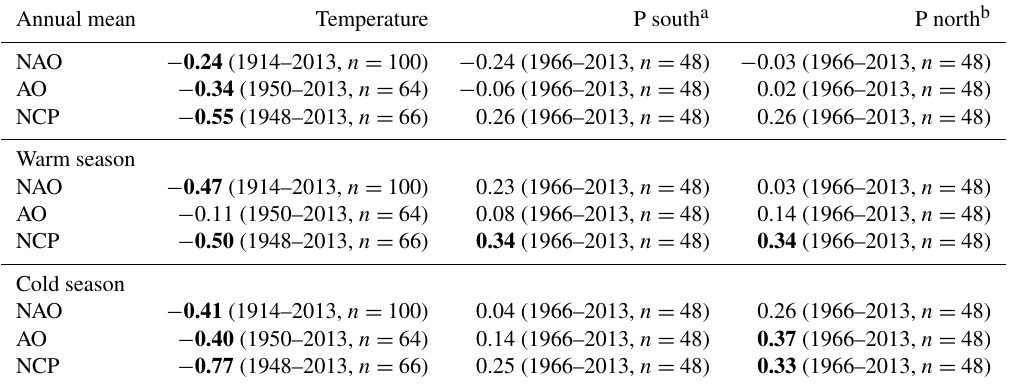
Table 2. Correlation coefficients between meteorological data and indices of large-scale modes of variability (statistically significant co- efficients at p < 0 . 05 are highlighted in bold). The period of calculation and number of data points ( n ) for each coefficient are shown in